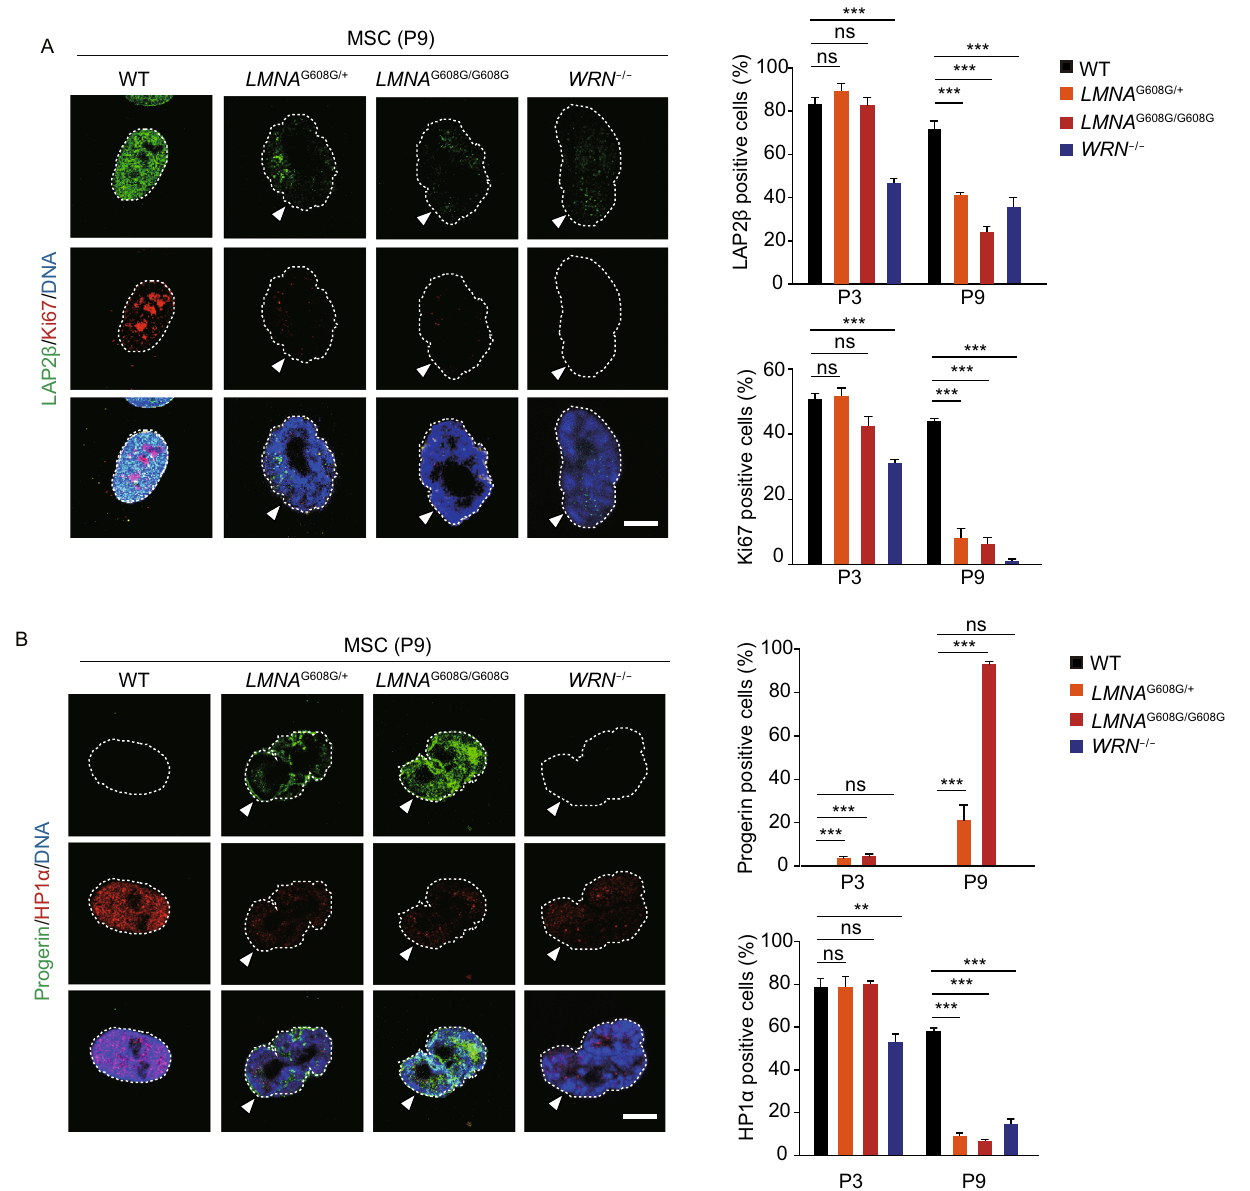
Figure 5. Immunostaining of aging-related markers in HGPS-MSCs and WS-MSCs demonstrates different aging kinetics. (A) Left: representative immunostaining of LAP2 β and Ki67 in WT, heterozygous ( LMNA G608G/+ ), homozygous ( LMNA G608G/G608G ) and WRN − / − MSCs. Dashed lines indicate the nuclear boundaries and white arrows indicate abnormal nuclei. Scale bar, 10 μ m. Right: percentages of LAP2 β positive cells (upper) and Ki67 positive cells (lower) were shown as mean ± SEM, number of cells ≥ 300. *** P < 0.001; ns, not signi fi cant. (B) Left: representative immunostaining of progerin and HP1 α in WT, heterozygous ( LMNA G608G/+ ), homozygous ( LMNA G608G/G608G ) and WRN − / − MSCs. Dashed lines indicate the nuclear boundaries and white arrows indicate abnormal nuclei. Scale bar, 10 μ m. Right: percentages of progerin positive cells (upper) and HP1 α positive cells (lower) were shown as mean ± SEM, number of cells ≥ 300. *** P < 0.001; ** P < 0.01; ns, not signi fi